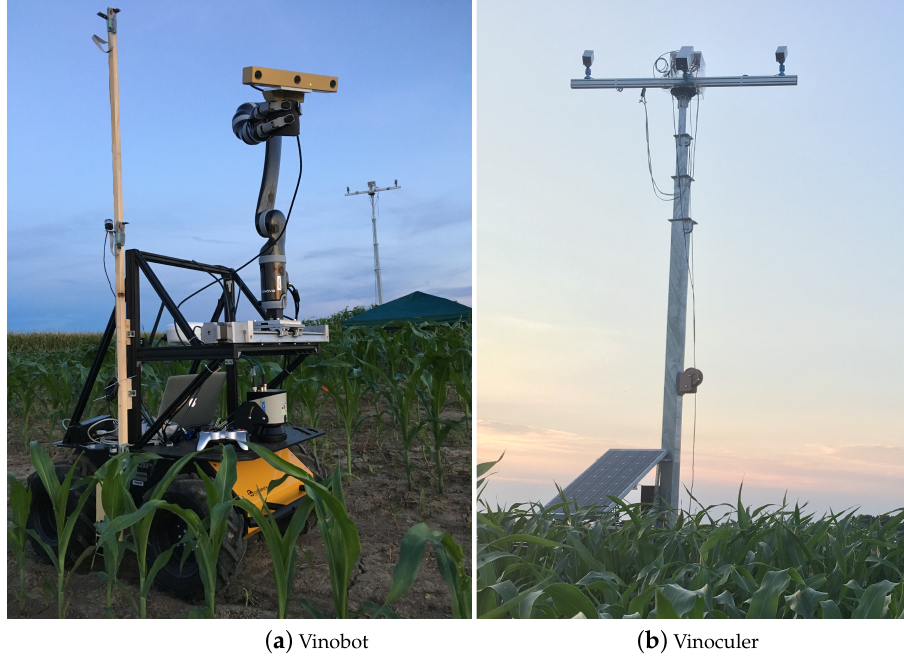
Figure 1. The proposed platforms for high-throughput phenotyping in the field deployed at the Bradford Research Center: ( a ) ground vehicle, Vinobot; and ( b ) observation tower, Vinoculer shown at 15 ft (4.5 m)